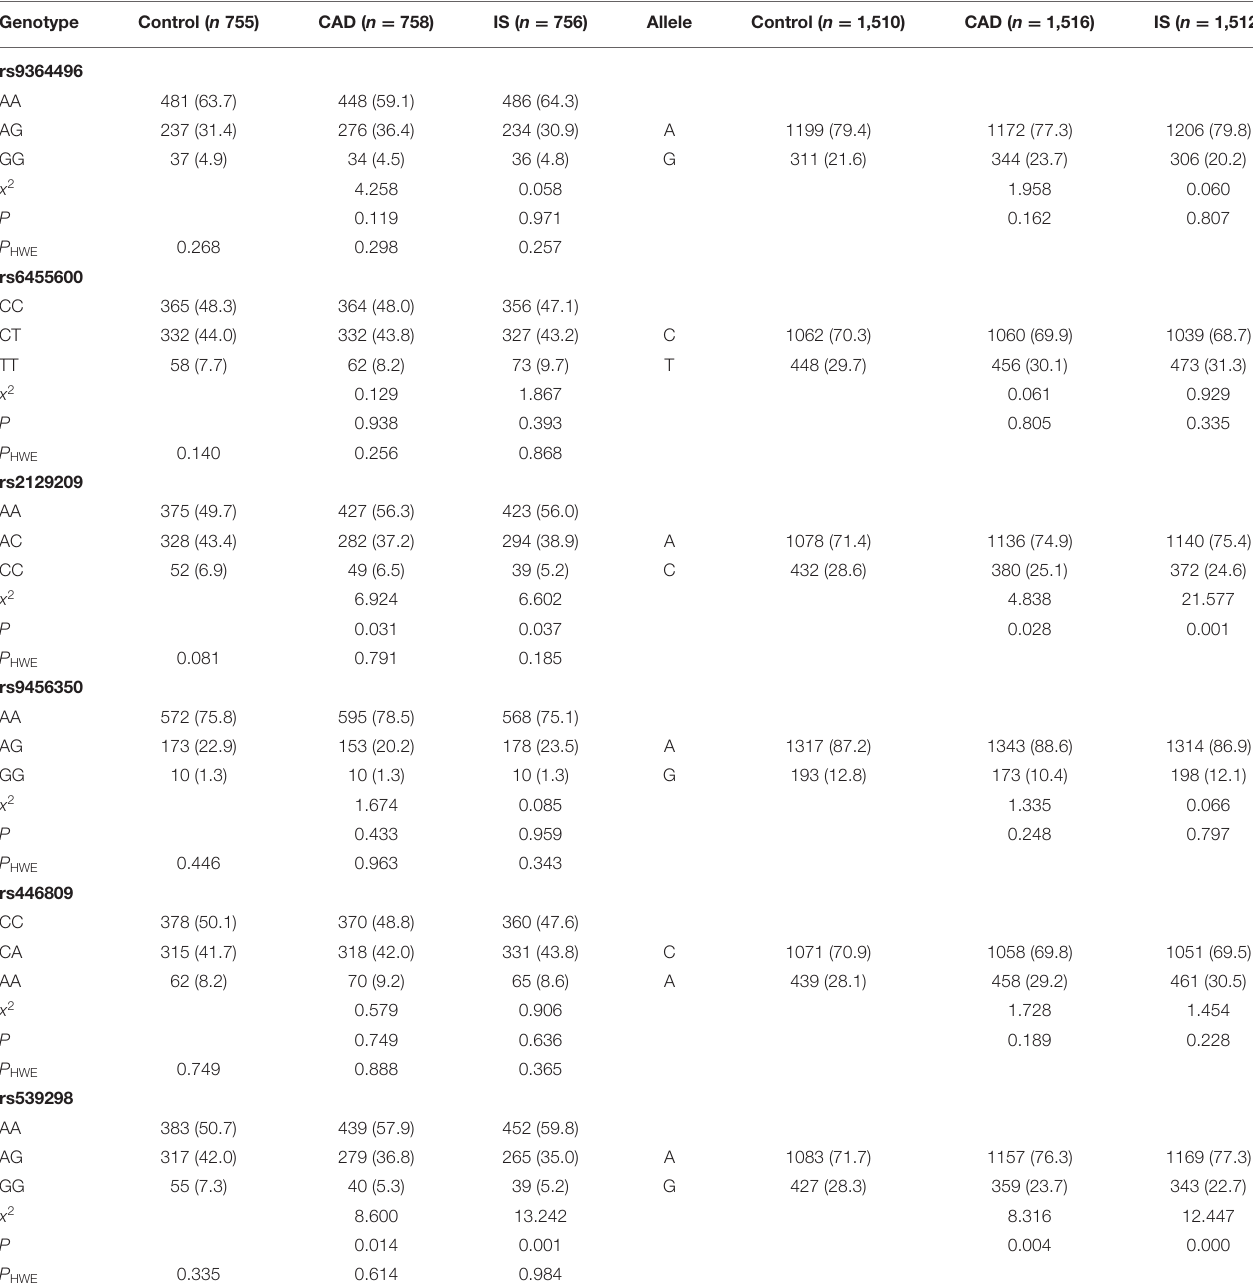
TABLE 2 | Genotype and allele frequencies of the 6 SYTL3 - SLCC2A3 SNPs in cases and controls [ n